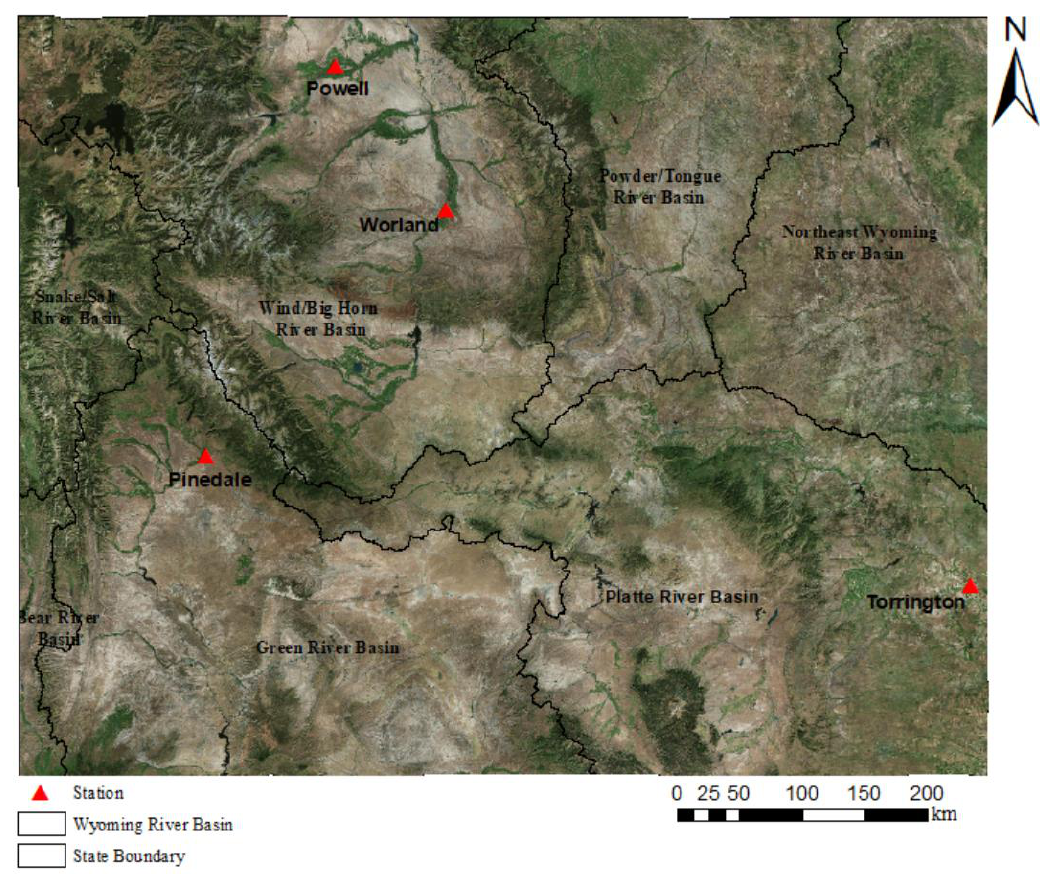
Figure 1. Major river basin regions and the location of selected stations in Wyoming.